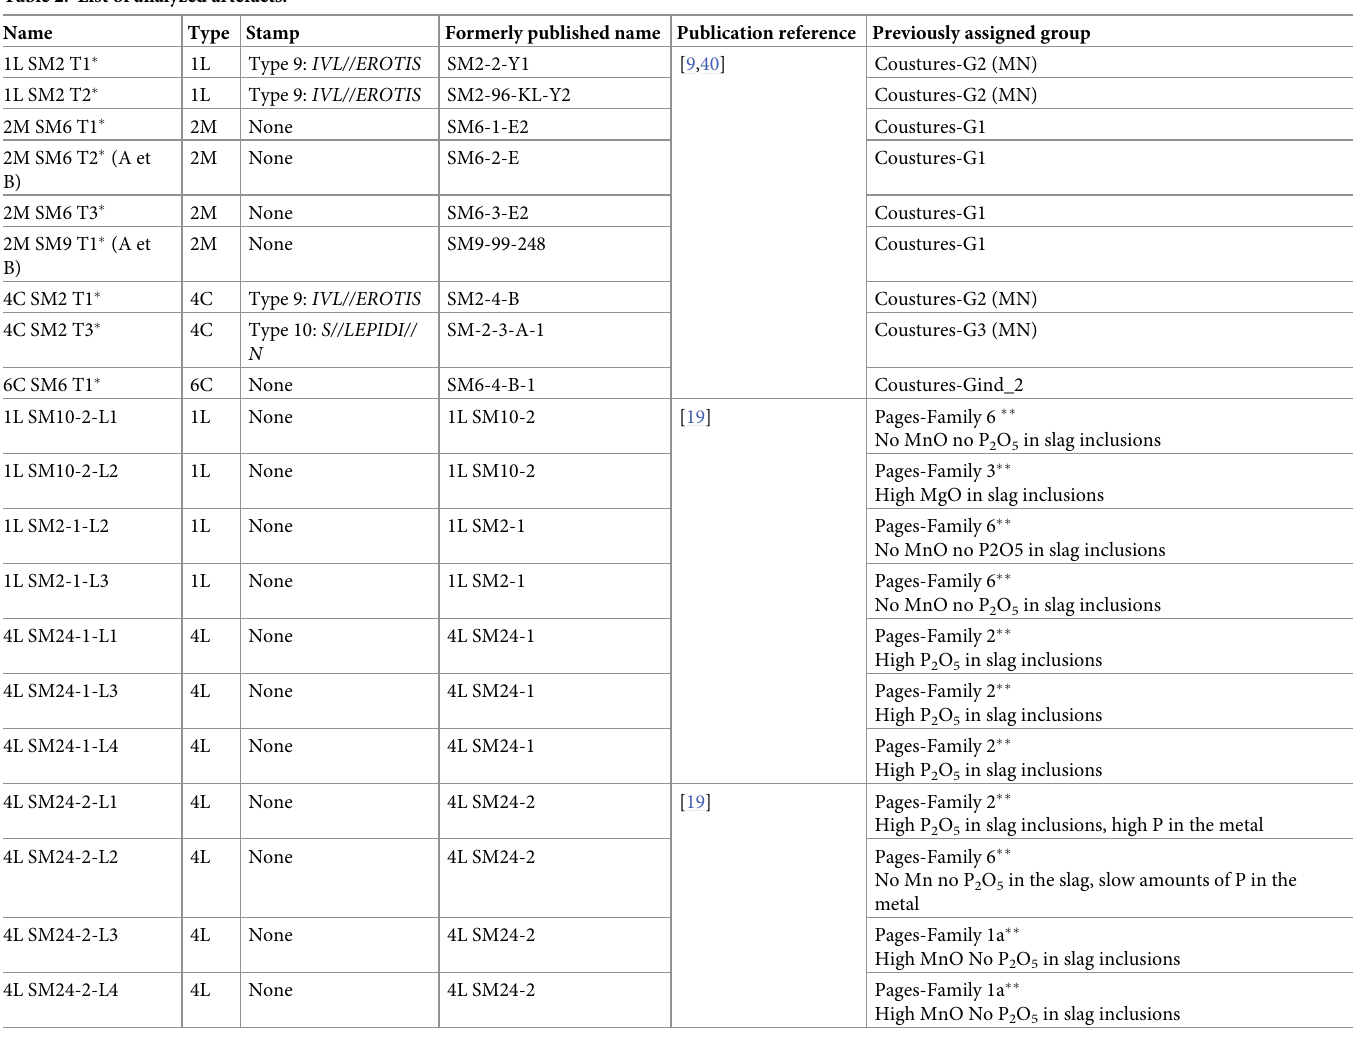
Table 2. List of analyzed